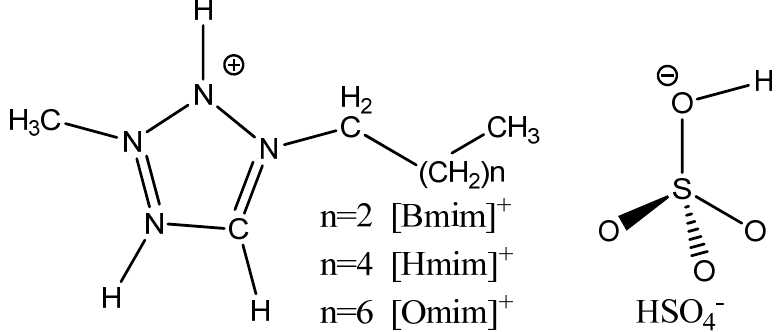
Figure 1. Schematic representation and the atom numbering for the studied ILs.